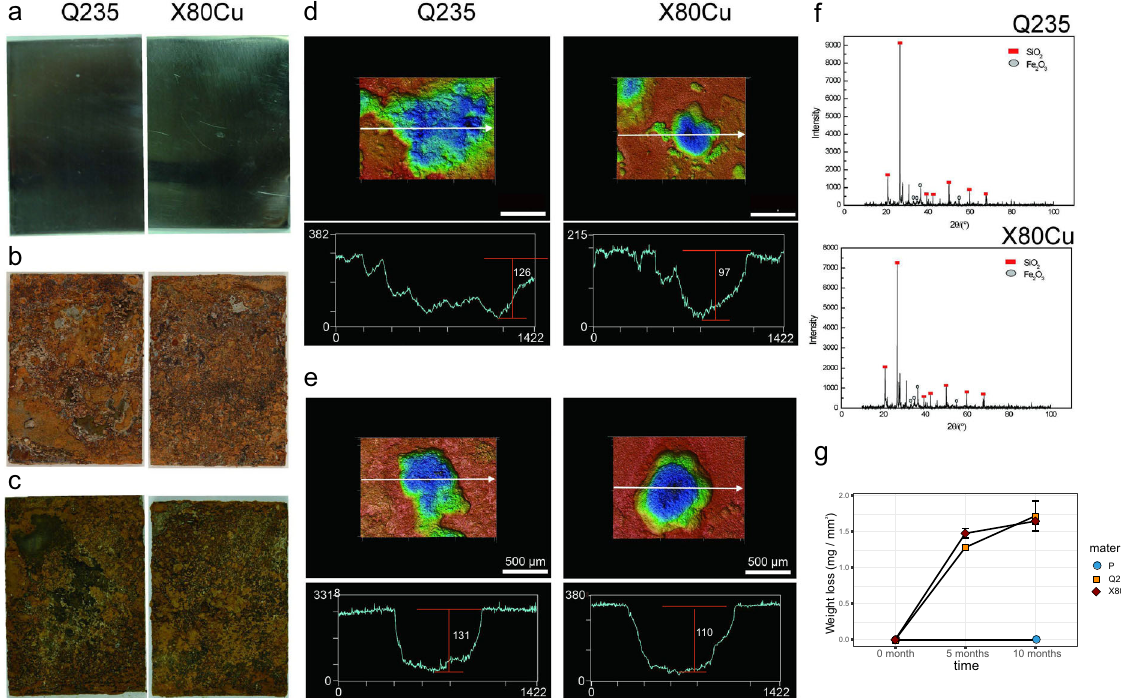
Fig. 1 Corrosion observations of buried materials. Surface morphology of metal samples before burial tests ( a ), after 5 months ( b ), and after 10 months ( c ) of burial tests. Confocal laser scanning microscopic images of the corrosion depths after 5 months ( d ) and after 10 months ( e ) of burial tests; scale bar represented 500 μ m. XRD analysis of crystalline phases of the corrosion products on the metal surfaces ( f ). Mass loss of materials ( g